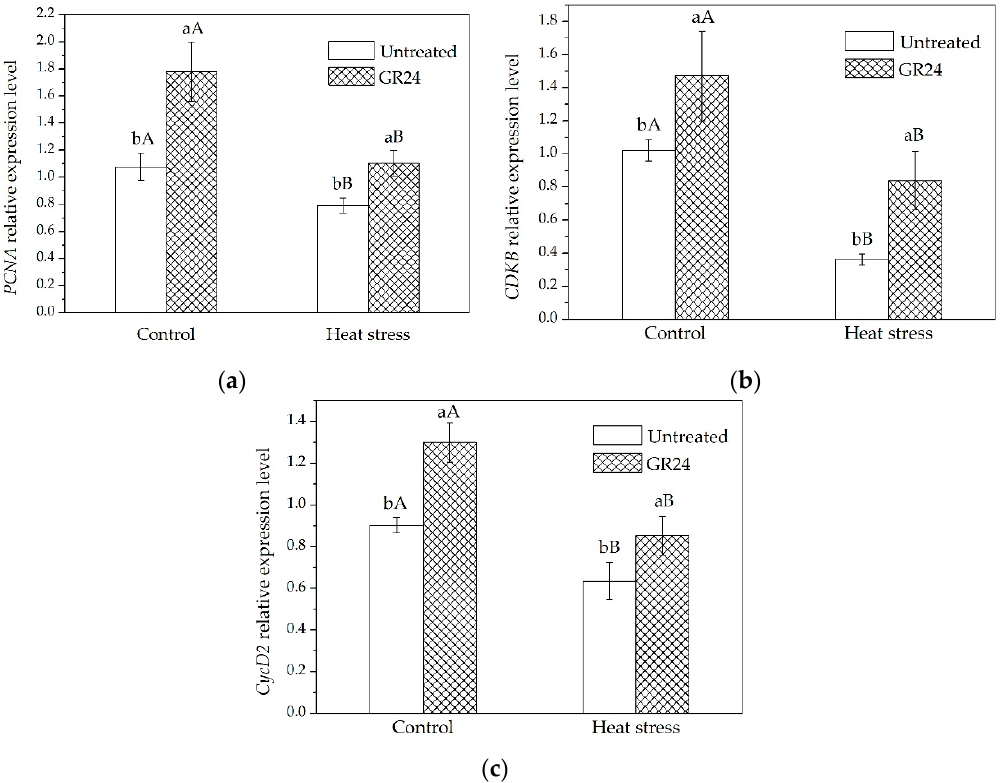
Figure 3. ( a ) PCNA expression level in leaves treated with or without GR24 under two different temperature regimes; ( b ) CDKB expression level in leaves treated with or without GR24 under two different temperature regimes; ( c ) CycD2 expression level in leaves treated with or without GR24 under two different temperature regimes. Lowercase letters are for comparison between different chemical treatments, and uppercase letters are for comparison between treatments under two temperature conditions.